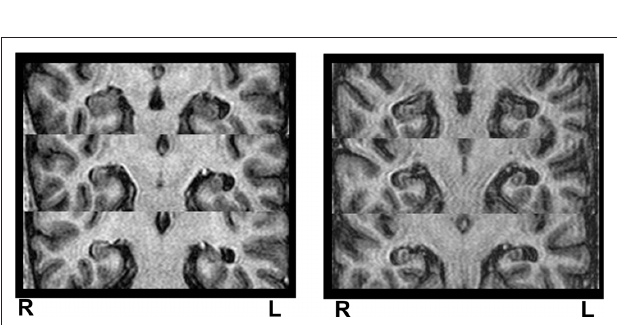
FIguRe 2 | Box and whisker plots: the bottom and top of the box represents the 25th and 75th percentile (the lower and upper quartiles, respectively), and the band near the middle of the box is the 50th percentile (the median). The “*” means outliers. Paired t -test comparing MRI1 and MRI2 showed a